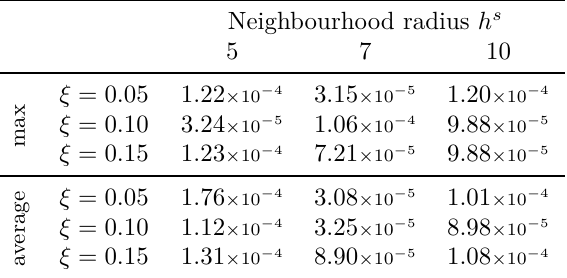
Table 6. Values of the two-point probability error ε S 2 , depending on the magnitude of artificially introduce noise ξ , neighbourhood radius h s , and the type of pooling layer used (max or